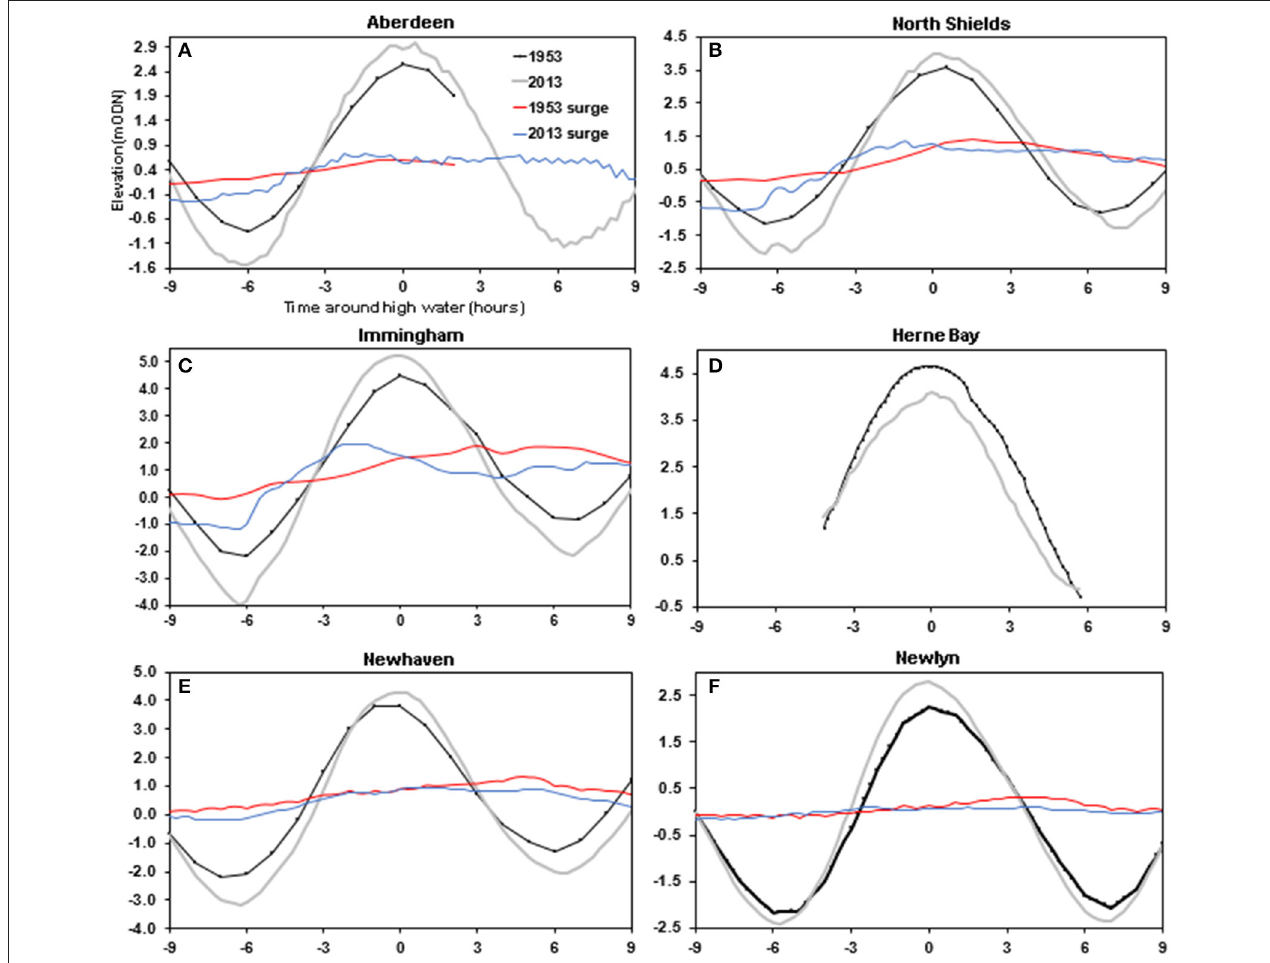
FIGURE 7 | Selection of 1953 and 2013 sea level time series recorded and corresponding surge values at: (A) Aberdeen, (B) North Shields, (C) Immingham, (D) Herne Bay, (E) Newhaven, and (F) Newlyn; with 1953 sea level and surge represented by the black and red lines, and the 2013 sea level and surge represented by the gray and blue